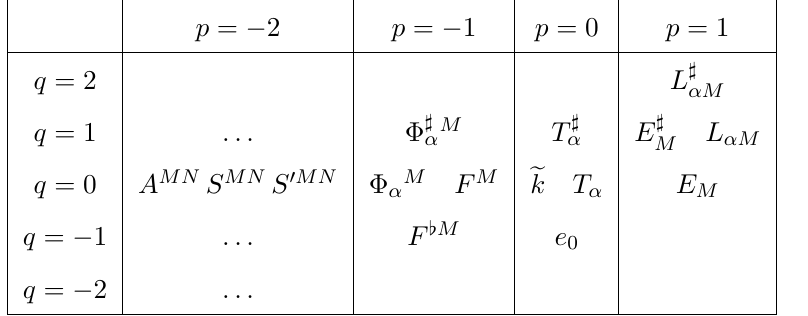
Basis elements for S ( g + ) , for finite-dimensional g , at p = − 2 , − 1 , 0 , 1 . At p = − 2 ,